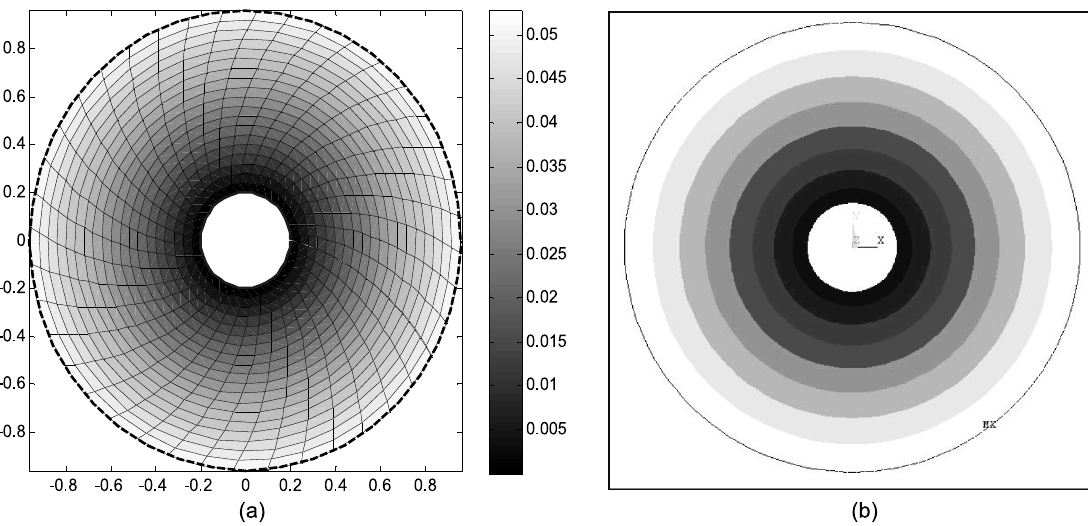
Fig. 5. Contour deformation plots for purely circumferential mode (0,0) for a ‘Clamped-Point Clamped’ disk: a) present analysis; b) Finite element model. is relaxed to the free edge. The results presented in Tables 1, 3 and 4 suggest that the frequency parameters of the disk with an outer edge point support are higher than those of the disk with the free outer edge. The effect of the point support is further investigated by varying the support stiffness on the frequency parameter, and the corresponding mode. The radial and circumferential stiffness parameters of the point support are varied from zero (free condition) to very large values (nearly clamped) condition. Figuer 3 illustrates the variations in the frequency parameters corresponding to selected modes with variations in the normalized stiffness parameters in the radial, ¯ K = K (1 − v 2 ) /E and circumferential, ¯ K = K (1 − v 2 ) /E , directions. The fi gure illustrates the frequency r pr θ pθ parameters of the selected odd and even modes, denoted by ‘O’ and ‘E’, respectively. The results clearly show considerable deviation in the frequency parameters corresponding to the even and odd modes when the stiffness parameters of the point support are increased. The two, however, converge to values identical to those in Table